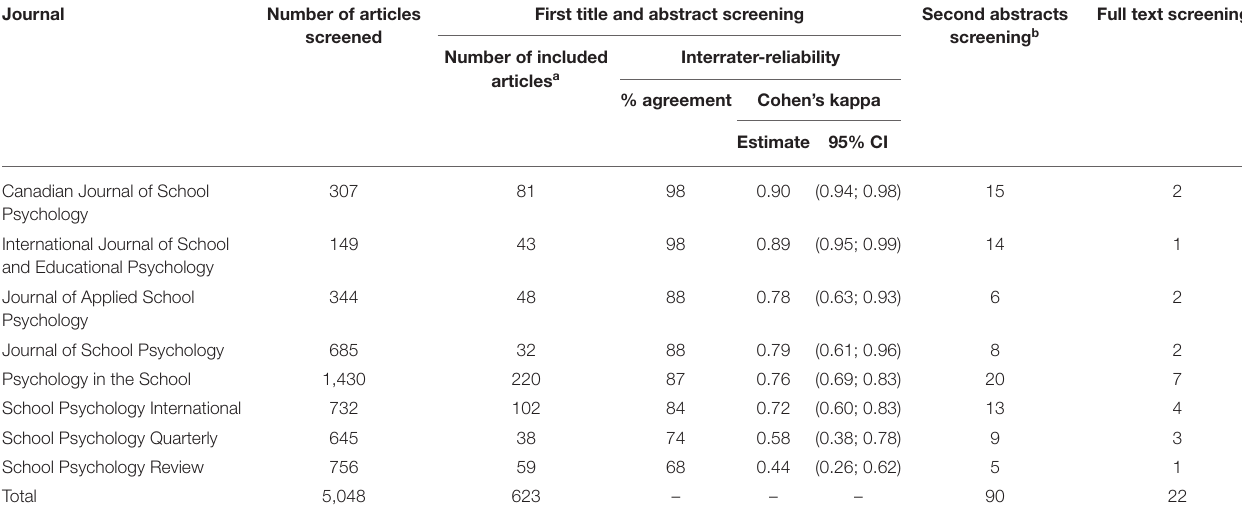
TABLE 2 | Summary of the procedure per journal (period: January 1998–September